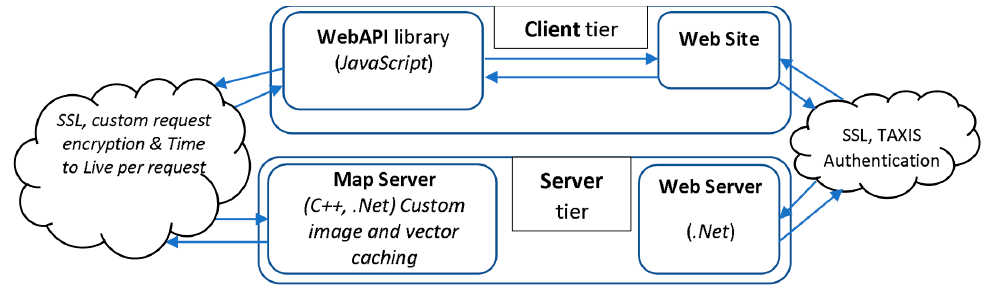
Figure 1. Technologies and relation between services.